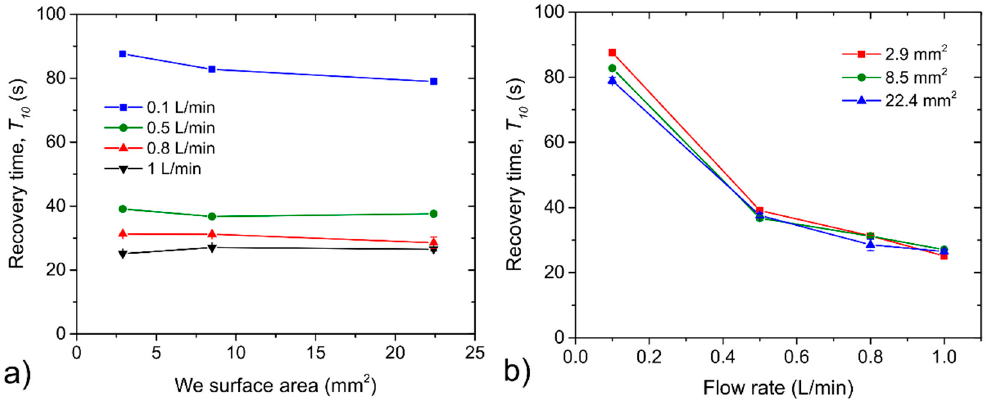
Figure 7. ( a ) Recovery time dependence on the WE surface area, ( b ) recovery time dependence on the analyte flow rate. The error bars represent Standard error of the mean that was calculated from three consecutive exposures to the same concentration.